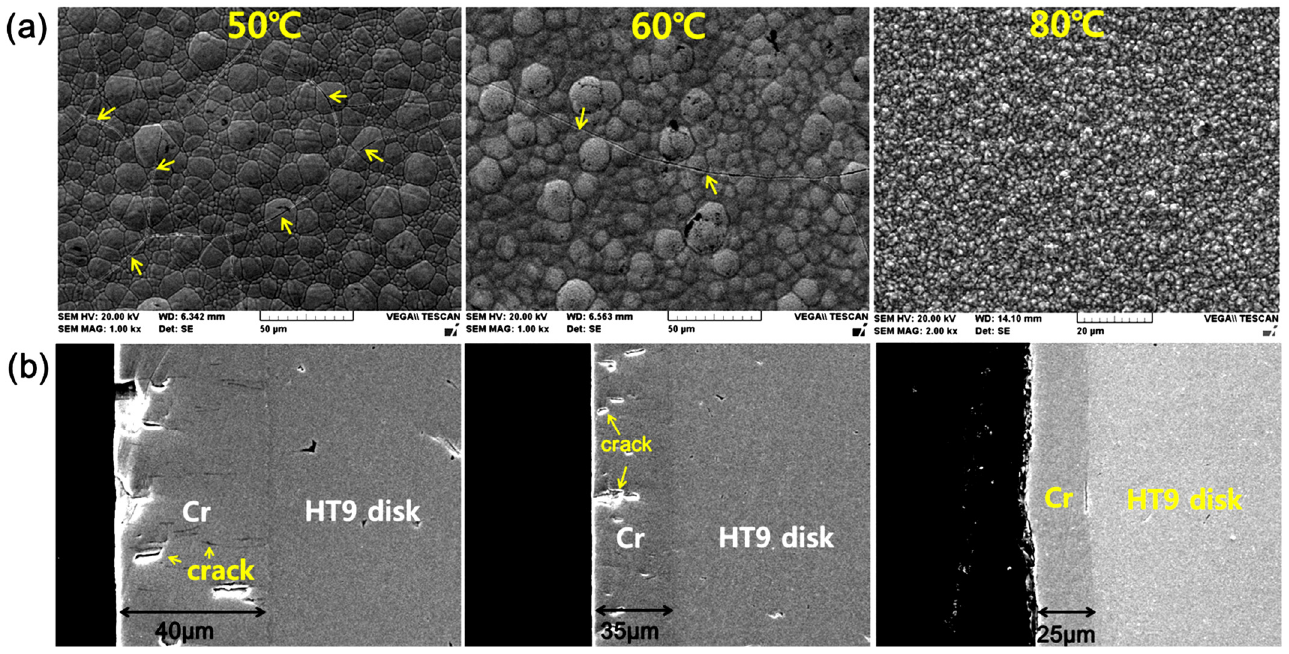
Figure 7. SEM micrograph of Cr coatings on HT9 cladding material with an increase in temperature: ( a ) surface morphology and ( b ) cross-sectional views. Reprinted with permission from [161]. Copy- right 2020 Elsevier. The SEM micrograph at 80 °C shows no crack formed on/in the Cr coating.